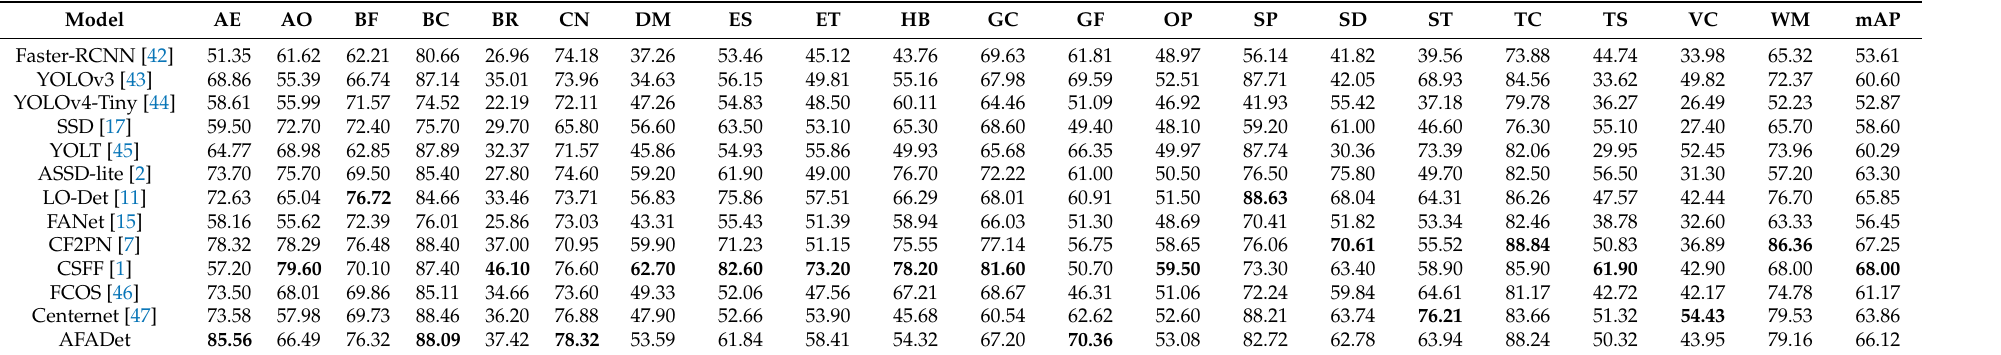
Table 1. mAP of each model for the DIOR